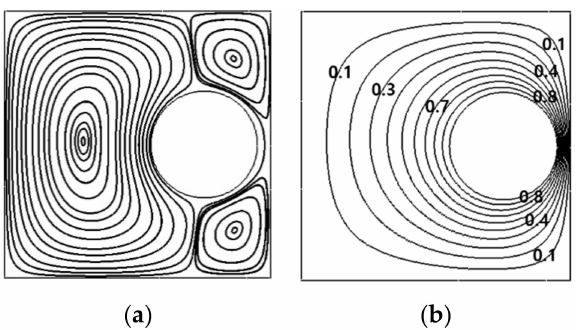
Figure 8. Streamline ( a ) and isotherm ( b ) at ( r = 0.25 L , θ = 0 ◦ ) in Mode IV for Ra = 10 3